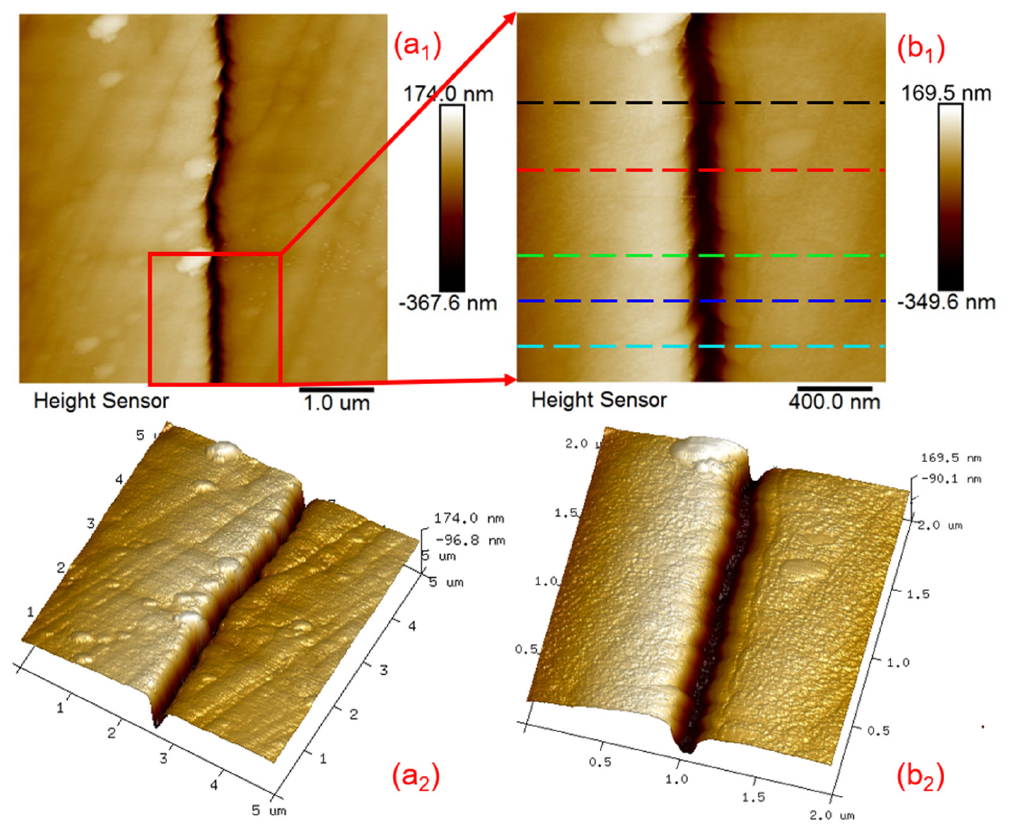
Figure 6. 2D images ( a 1 ,b 1 ) and 3D images ( a 2 ,b 2 ) of the microcrack morphology.